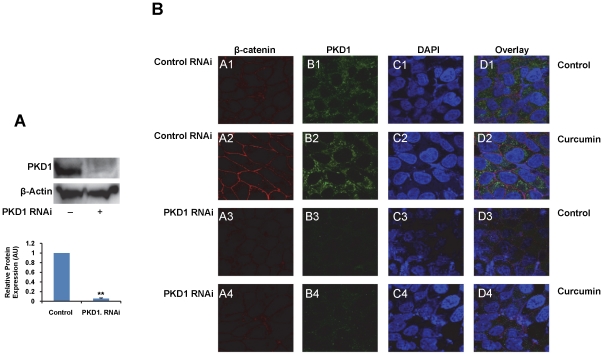
PKD1 is required for curcumin induced enrichment of β-catenin on the membrane.A). Silencing of PKD1 by PKD1 specific siRNA. C4-2 cells were transfected for 48 h with 25 nM control siRNA or PKD1 siRNA, lysed and immunoblotted for PKD1 and β-actin using specific antibodies. Quantitation of protein band intensities was performed by densitometric analysis. The PKD1 levels was normalized to β-actin levels and graphed. AU- arbitrary units. Immunoblotting shows over 95% suppression of PKD1 expression on transfection with PKD1 specific siRNA (lane 2) compared to control siRNA-transfected cells (lane 1). B). Suppression of PKD1 inhibits enrichment of membrane β-catenin levels. C4-2 cells were cultured on coverslips overnight. The cells were first transfected with either control siRNA (A1–D1; A2–D2) or PKD1 silencing siRNA (A3–D3; A4–D4) for 24 h, followed by treatment with vehicle control (DMSO) (A1–D1; A3–D3) or curcumin (20 µM) (A2–D2; A4–D4) for 1 h. The cells were immunostained for β-catenin (red) or PKD1 (green) and the nucleus was counter stained with DAPI (blue). Higher β–catenin staining was observed on the cell surface of control siRNA cells at 1 h of curcumin treatment (A2) compared to vehicle treatment (A1). However, siRNA mediated silencing of PKD1 (B3, B4) inhibited curcumin mediated enrichment of membrane β–catenin staining on the cell surface (A4 vs A3 and A2). Original Magnifications 600× with 2× zoom.